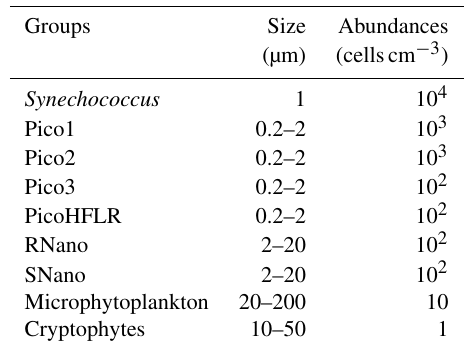
Table 2. Size and abundances of the nine phytoplankton groups, identified by flow cytometry analysis in Fig.